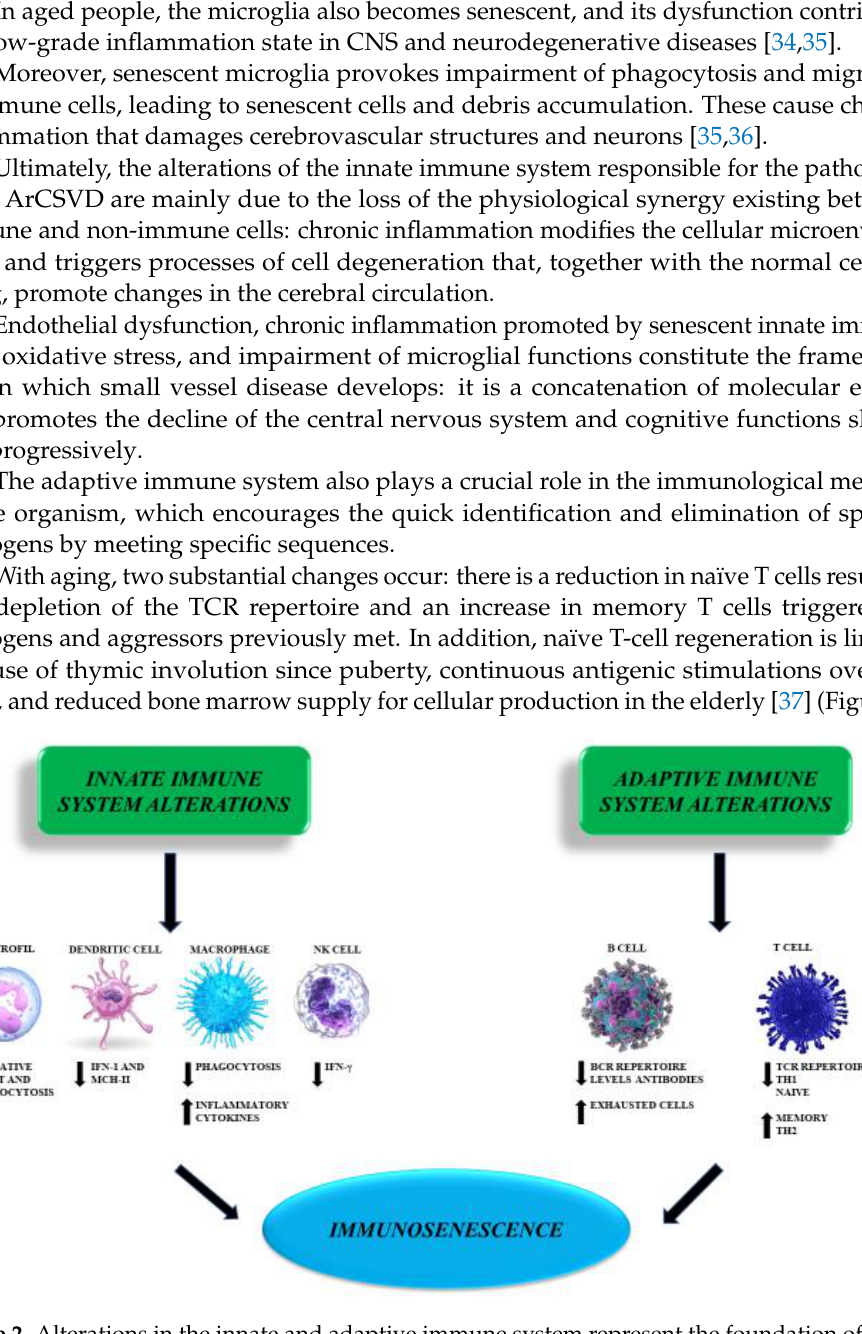
Figure 2. Alterations in the innate and adaptive immune system represent the foundation of those changes that the organism, as it ages, faces—immunosenescence and the alterations in molecular mechanisms that it presupposes are a cornerstone of the pathophysiology in ArCSVD.